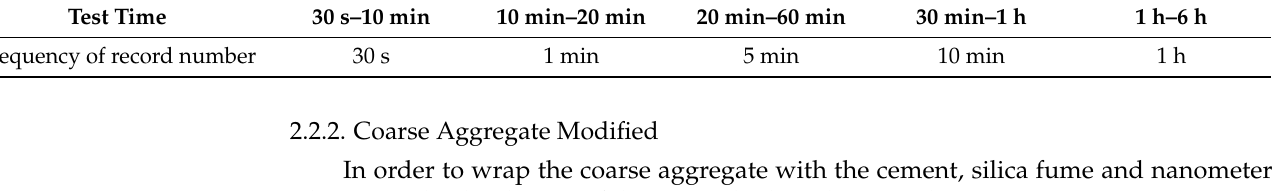
Table 7. The principle for recording the number.